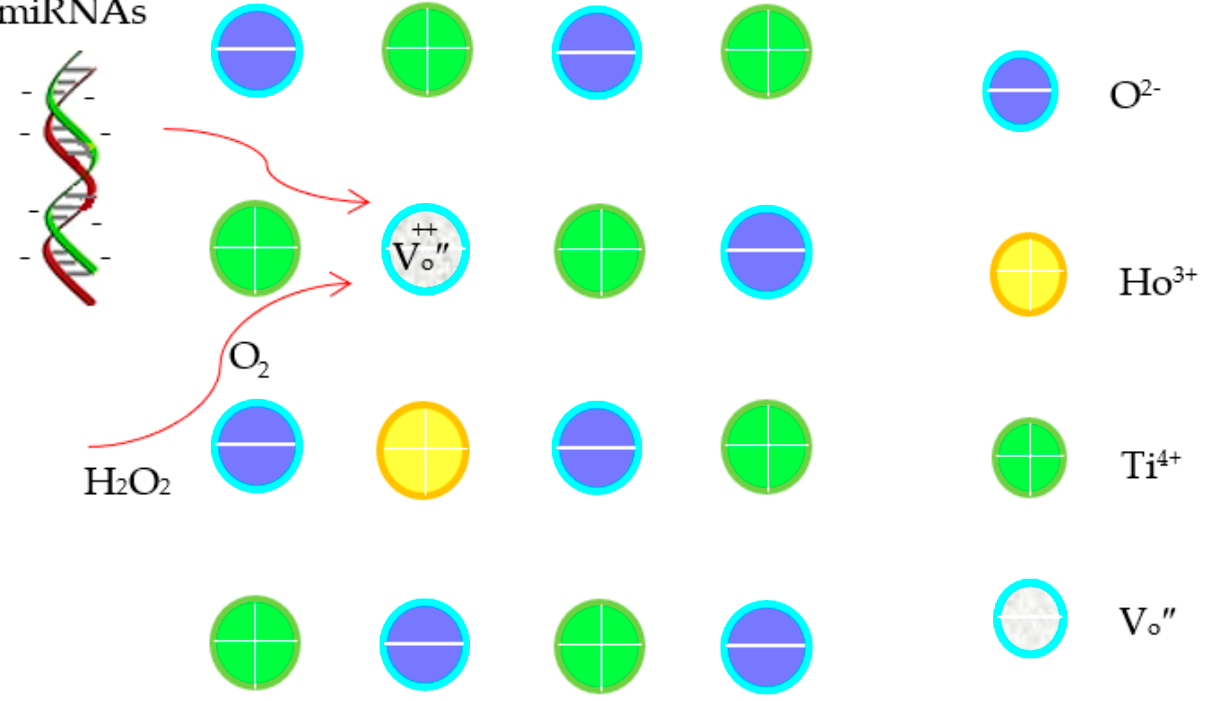
Scheme 1. The illustration for a mechanism of the electrochemical detection of cancer miRNAs.